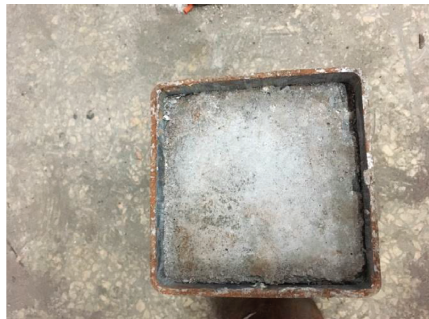
Figure 3: Failure